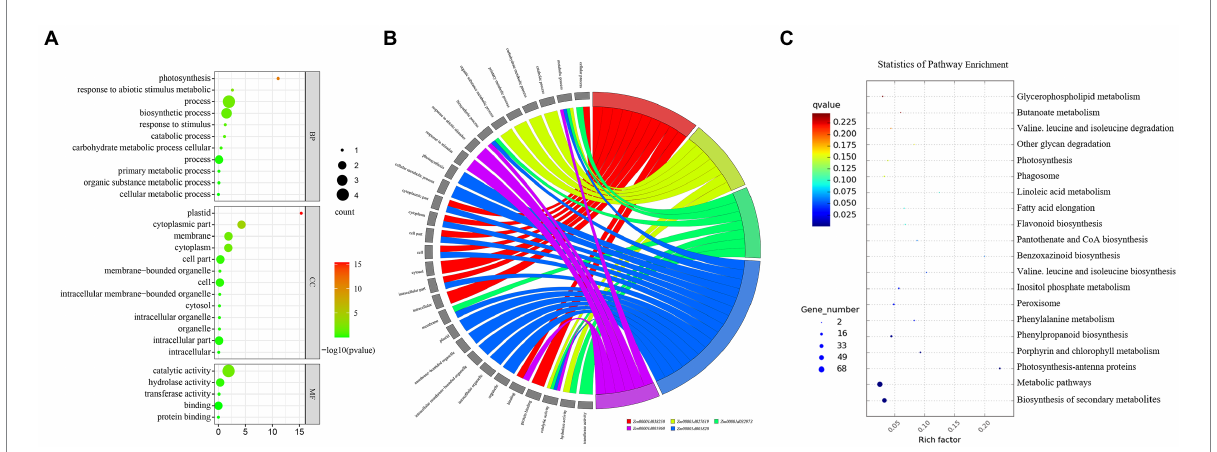
FIGURE 5 GO annotations and KEGG pathways of DEGs. (A) Bubble chart of GO classifications of five DEGs. (B) Chord chart of GO annotation corresponding to five DEGs. (C) The red box is the KEGG pathway map of Zm00001d02761, Zm00001d001820, and Zm00001d001960 genes.